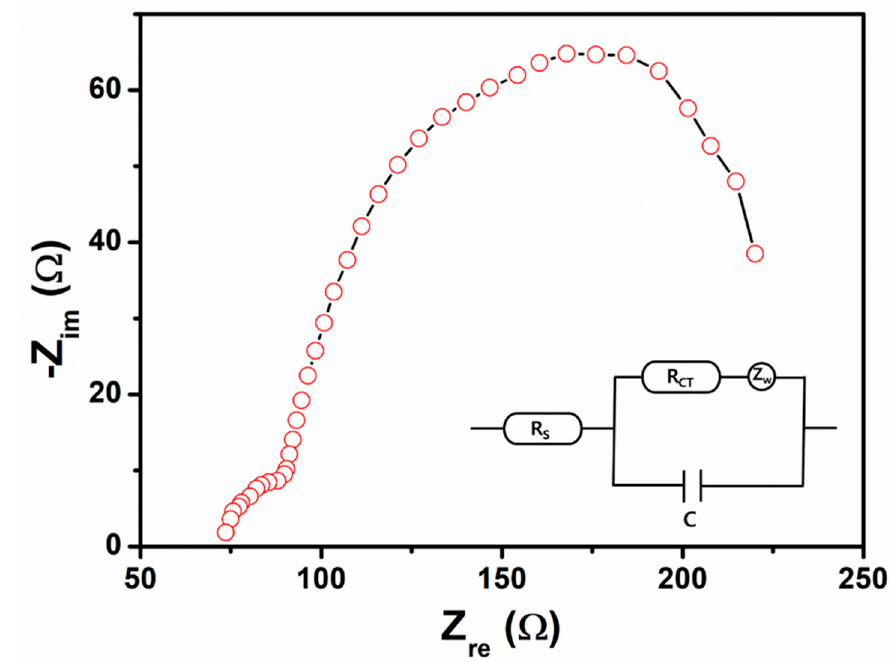
Figure 7. Nyquist plot of fabricated DSSC with flower-shaped ZnO nanostructure-based photoanode and inset shows equivalent circuit of fabricated device.